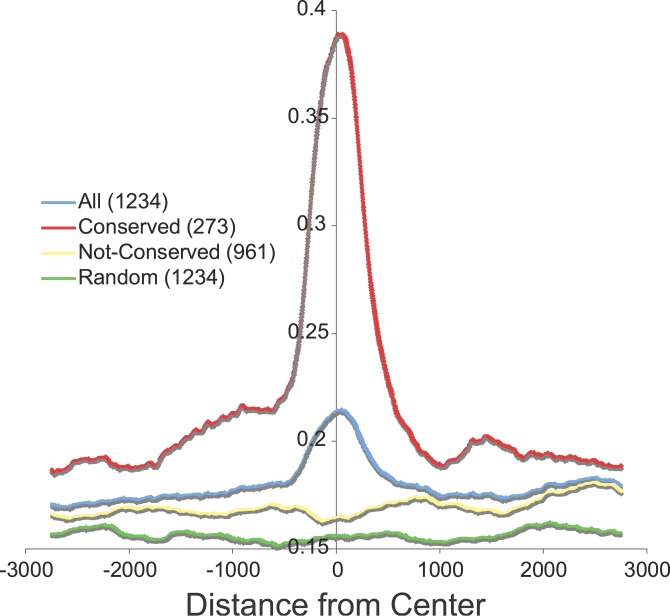
Most of the Sequences Flanking the 1,234 ER Binding Sites Are Not Conserved through EvolutionMeasure of species conservation at all 1,234 ER binding sites from the center of the ChIP-PET cluster is depicted in the blue line. The green line measures species conservation of randomly selected fragments. The red line depicts the degree of conservation in 22% (273/1,234) of the binding sites bearing conserved elements, and the yellow line shows the degree of species conservation of the remaining 78% (961/1,234) of the binding sites that harbor no conserved elements. These results show that most of the conservation signal is driven by a minority of the binding sites. Conservation was measured by base-by-base comparisons.